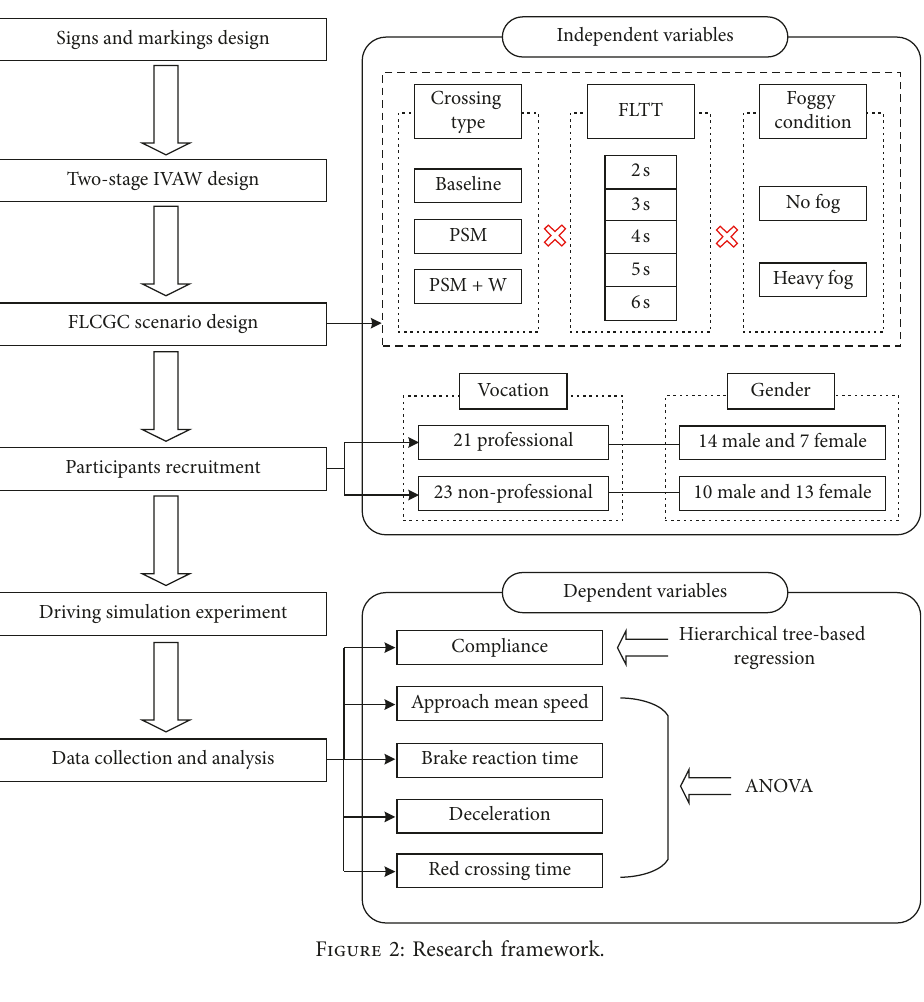
Figure 2: Research framework.